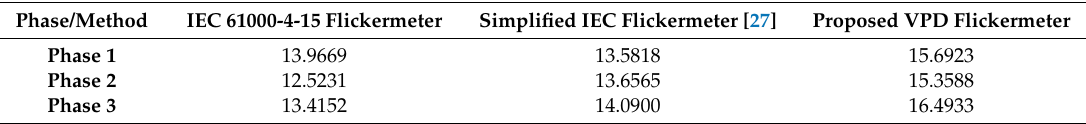
Table 9. P st values of each phase for different